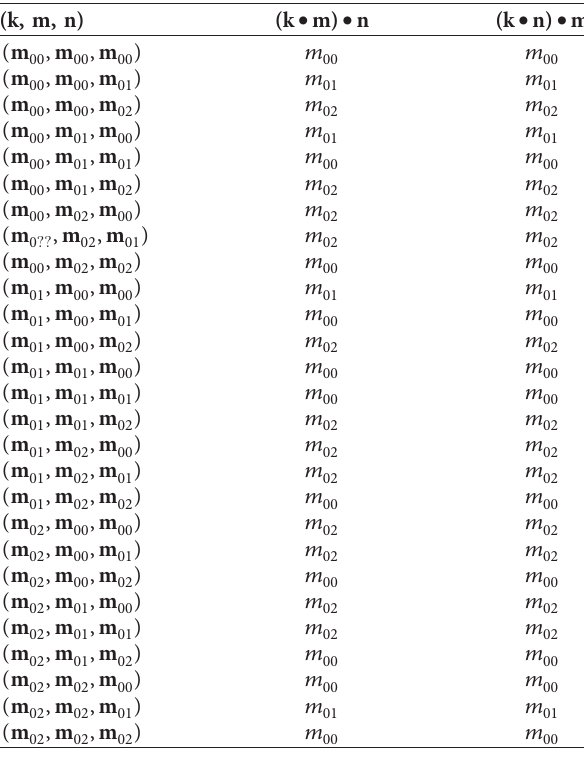
In Table 4, the value for λ p verified from Table 5.